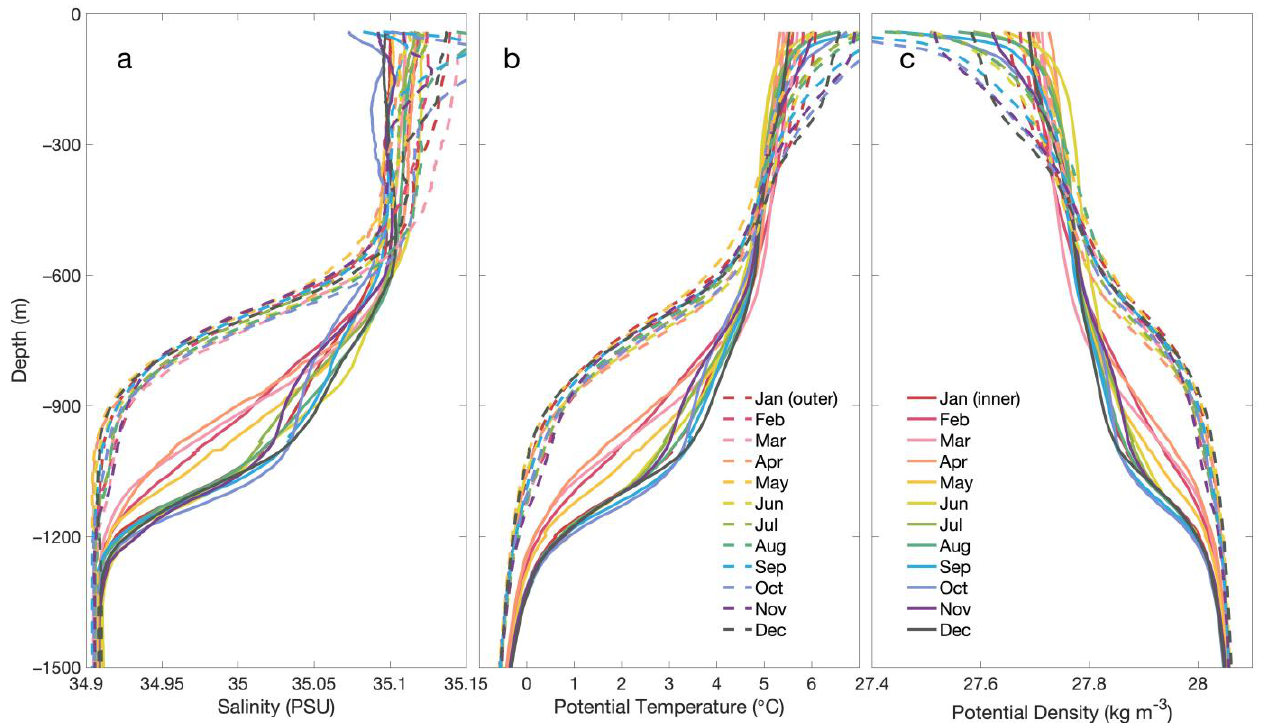
Figure 7. Climatological monthly ( a ) salinity, ( b ) potential temperature, and ( c ) potential density profiles. The solid profiles are in the inner circle of the CLV within a radius of 60 km. The dashed profiles are in the outer ring of the CLV within a radius of 60–120 km.